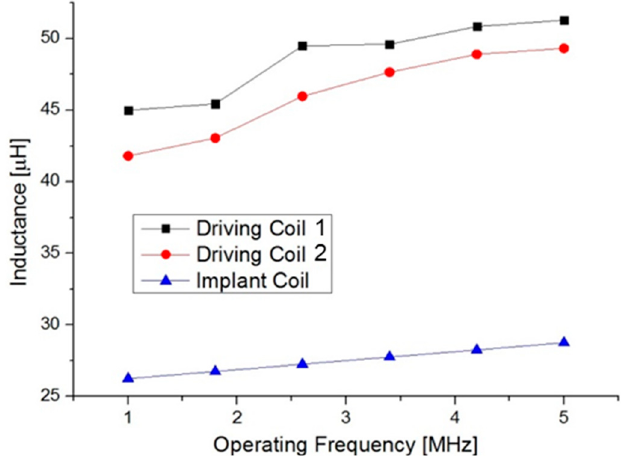
Figure 3. Inductance simulation of driving coils and implant coil with multi-layer and multi-turn versus different frequency.